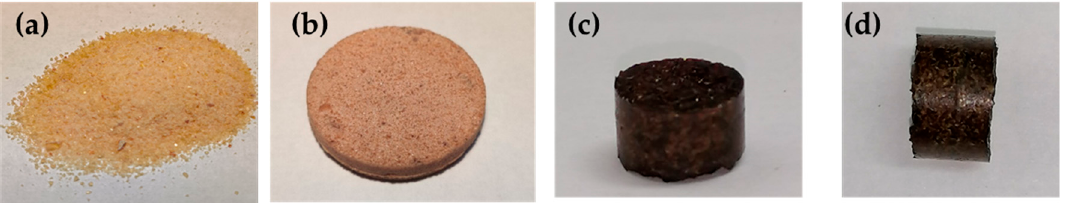
Figure 7. ( a ) Grinded powder from 4-DGA-0.5-Zn networks. ( b ) Remolded test specimen obtained by applying 5 bar at 220 °C. The diameter of the disc is 25 mm. ( c , d ) Remolded test specimen obtained by applying 500 bar at 250 °C. The diameter of the cylinder is 7 mm.